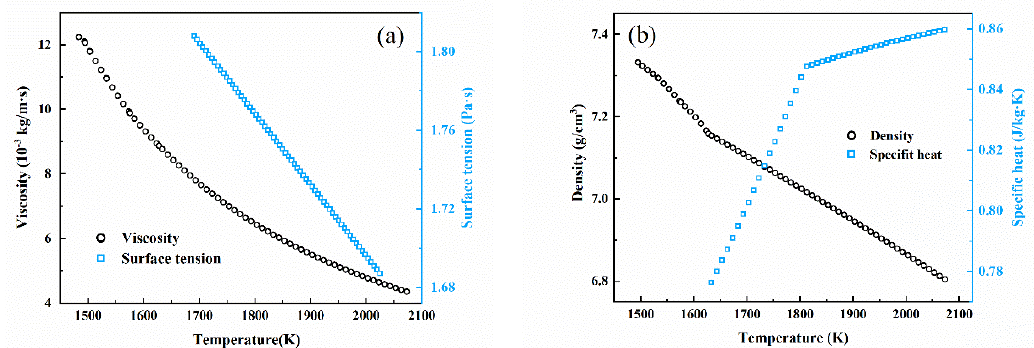
Figure 4. Relationship between the physical properties of FeNiCrBSiNbC alloy molten melt and temperature: ( a ) viscosity and surface tension; ( b ) density and specific heat.